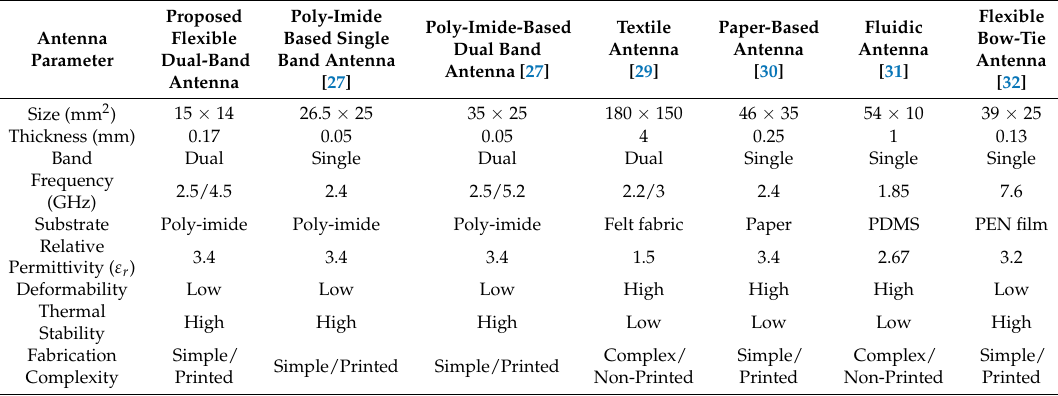
Table 1. Comparison of different types of flexible antennas.